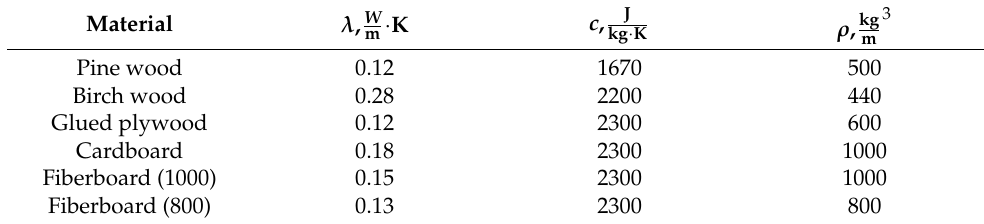
Table 1. Thermophysical characteristics of materials [62].